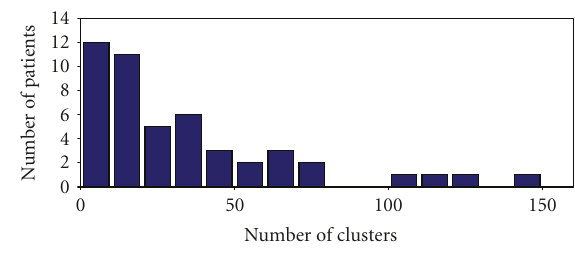
Figure 2: Histogram of clusters per patient: the number of clusters determined automatically per patient is distributed as shown, with a median value of